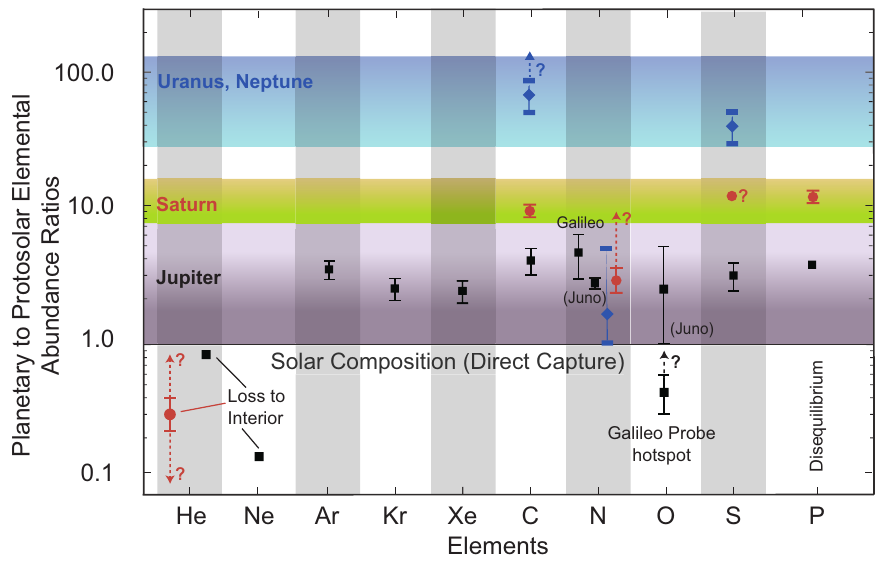
Figure 24. The elemental abundances in the atmospheres of all giant planets with respect to proto- solar values (Jupiter: black symbols; Saturn: red; Uranus/Neptune: blue). Values marked with “?” are either uncertain (N, S, He) or may not be representative of the actual ratio in the deep atmosphere. See Atreya et al. [210] for the possible range in Saturn’s helium abundance, shown here by upward and downward pointing arrows. We added S and N values for Saturn, Uranus, and Neptune as discussed in this review, and used the C value for the Ice Giants as derived by Sromovsky et al. [211]. (Figure adapted from Atreya et al. [210] in Saturn—The Grand Finale (K. Baines, et al. eds.), Cambridge University Press. Preprint: